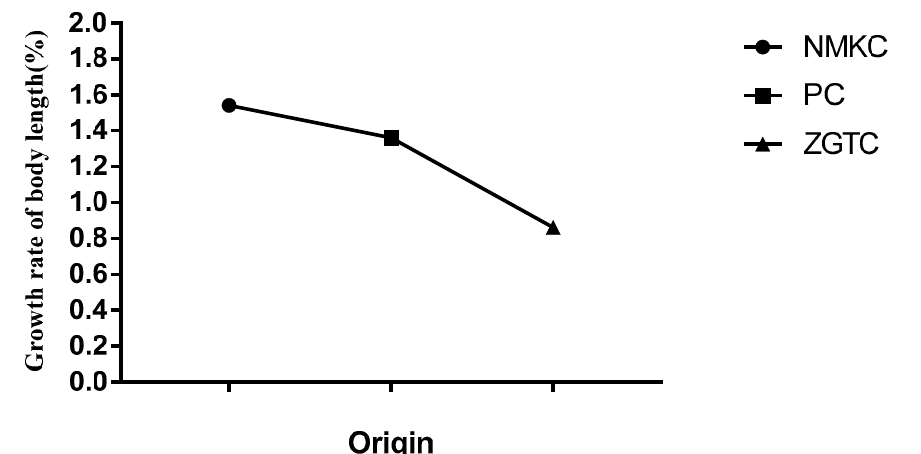
Figure 4. Growth rate of body length of Daphniopsis tibetana from different origins. Means with different lowercase letters are significantly different ( p < 0.05).